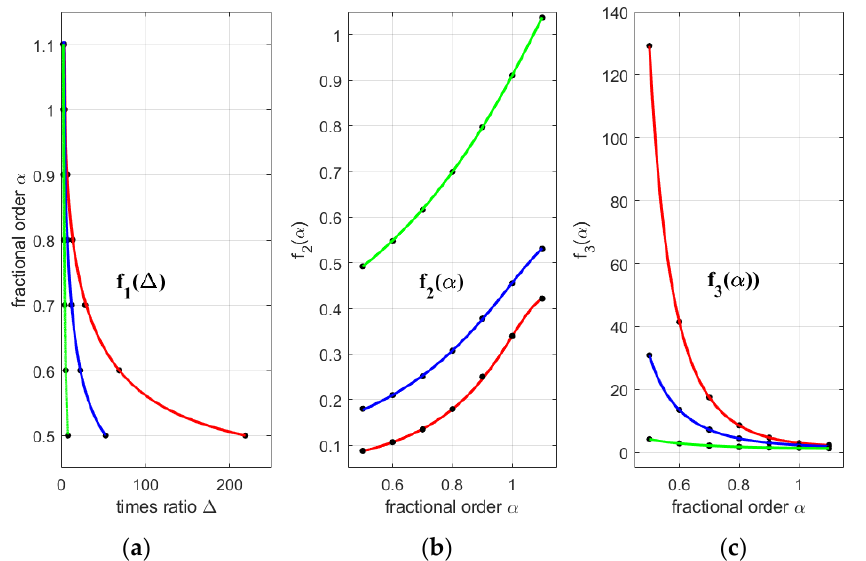
Figure 5. Data sets and results of curve fitting for symmetrical sets of points, (5-50-95%), (10-50- 90%), and (25-50-75%), respectively: ( a ) Data sets {Δ, α} and curve fitting for f 1 (∆); ( b ) Data sets {α, a α } and curve fitting for f 2 (α); ( c ) Data sets {α, (τ 100‒x ) 1/α } and curve fitting for f 3 (α). Note that in each graph, curve fitting for (5-50-95%) is represented in red, (10-50-90%) in blue, and (25-50-75%) in green.